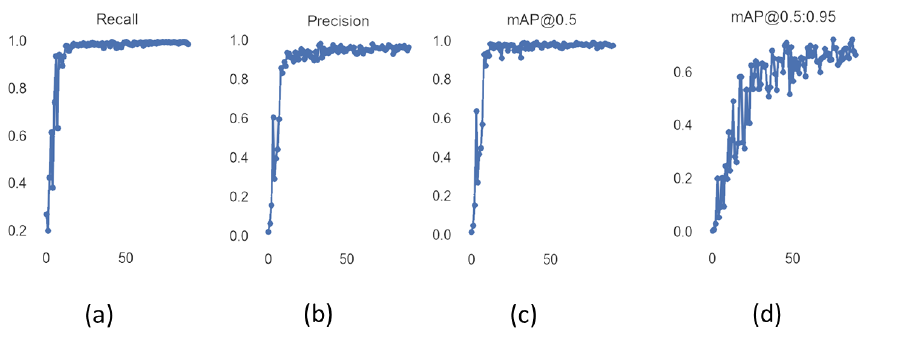
Figure 11. ( a , b ) represent the recall and precision values of YOLOv5s during training with increasing epochs; ( c ) mAP@0.5 represents mAP values with the IOU threshold value as 0.5; ( d ) mAP@0.5:0.95 represents mAP values with different IOU threshold values that range from 0.5 to 0.95 with step size of